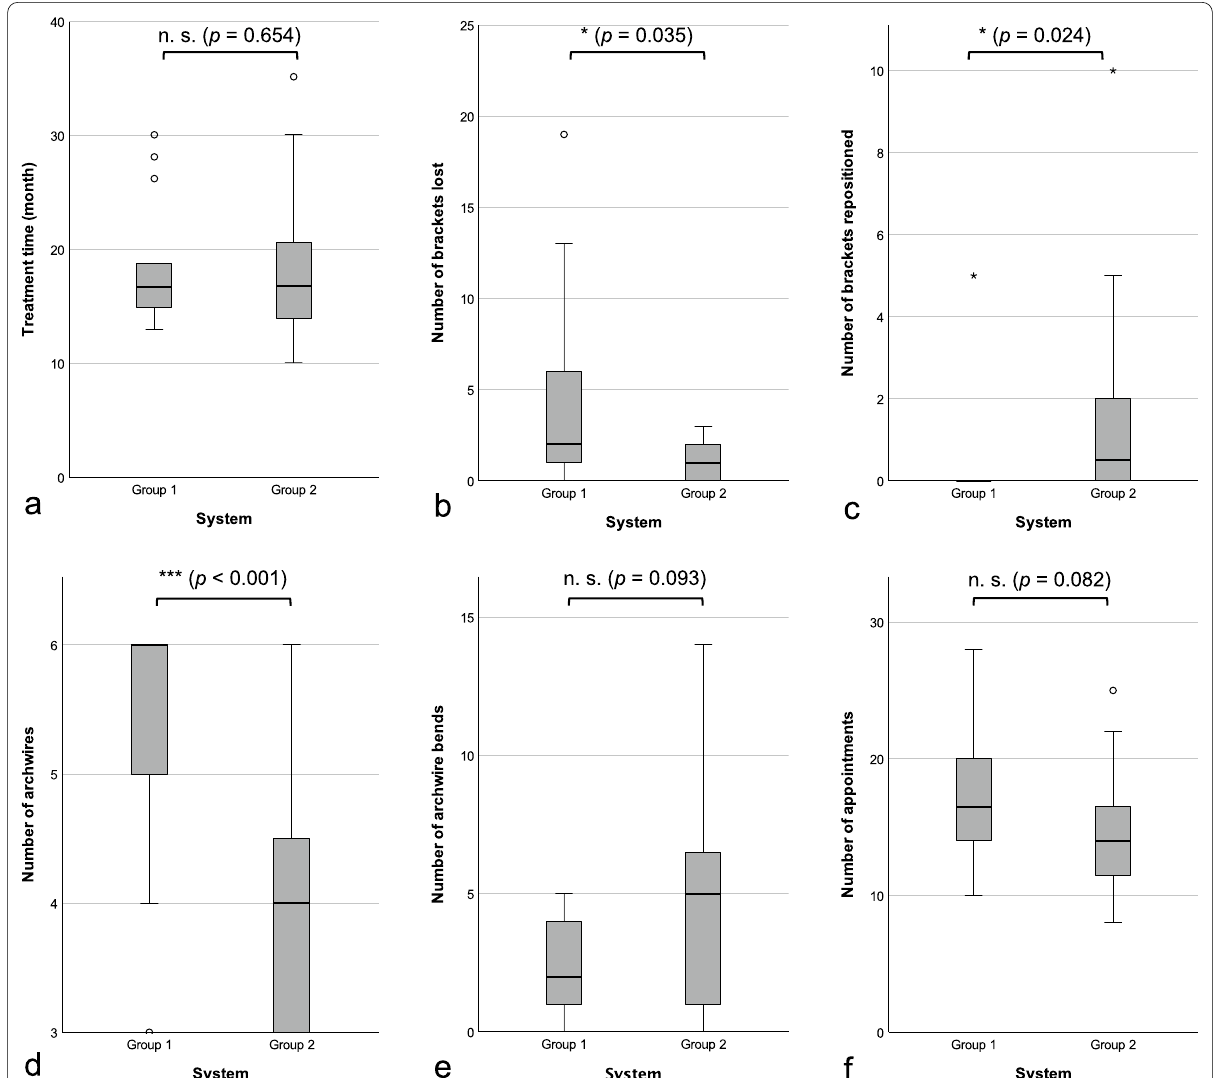
Fig. 1 Distribution of treatment time ( a ), and the number of brackets lost ( b ), brackets repositioned ( c ), archwires used ( d ), archwire bends ( e ), and appointments ( f ) in groups 1 and 2. Pairwise comparisons were done using the Mann–Whitney U test and their test statistics (n.s., not significant; *, p < 0.05; ***, p < 0.001)